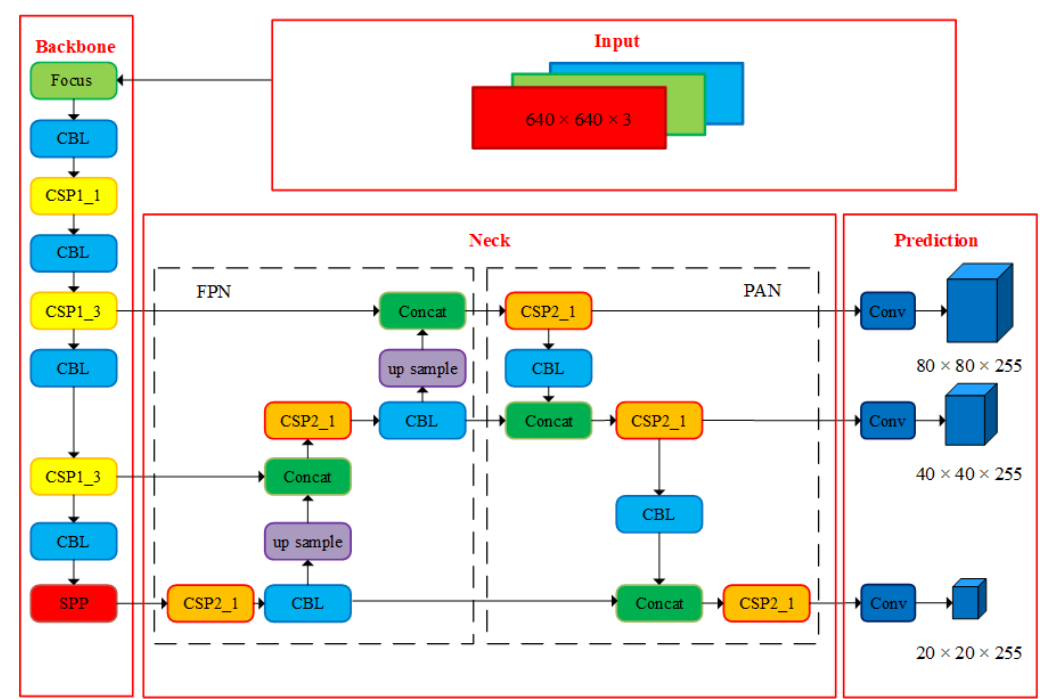
Figure 6. YOLOv5s structure diagram.